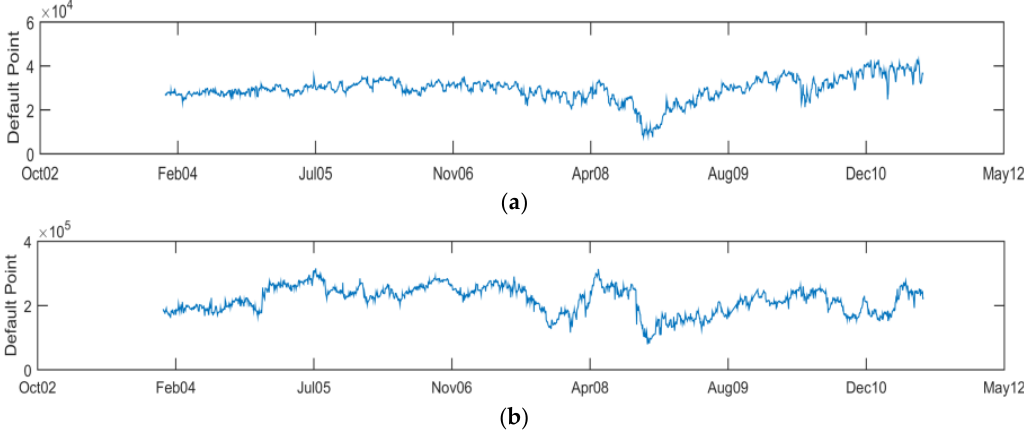
Figure 5 . Implied default point for (a) Boeing Co (in USD millions) and (b) Hutchison Whampoa (in Figure 5. Implied default point for ( a ) Boeing Co (in USD millions) and ( b ) Hutchison Whampoa HKD millions). (in HKD